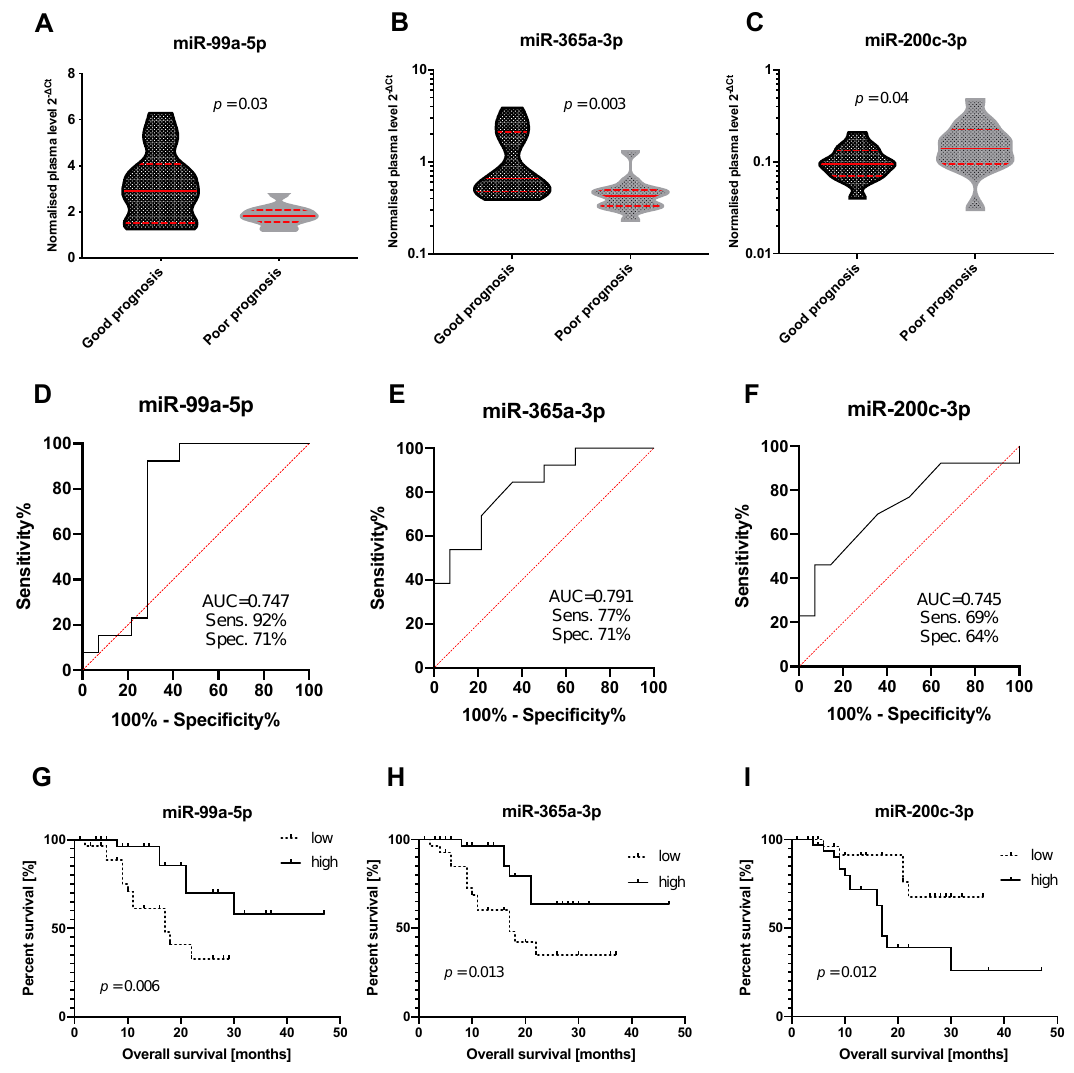
Figure 1. miRNAs with significantly different levels in blood plasma of pancreatic ductal adenocarcinoma (PDAC) patients with good and poor prognosis after surgical resection. Results of Mann–Whitney U-test for miR-99a-5p ( A ), miR-365a-3p ( B ), and miR-200c-3p ( C ); ROC analysis for miR-99a-5p ( D ), miR-365a-3p ( E ) and miR-200c-3p ( F ); and Kaplan-Meier survival analysis for miR-99a-5p ( G ), miR-365a-3p ( H ) and miR-200c-3p ( I ). AUC: Area under the curve; Sens.: Sensitivity; Spec.: Specificity.